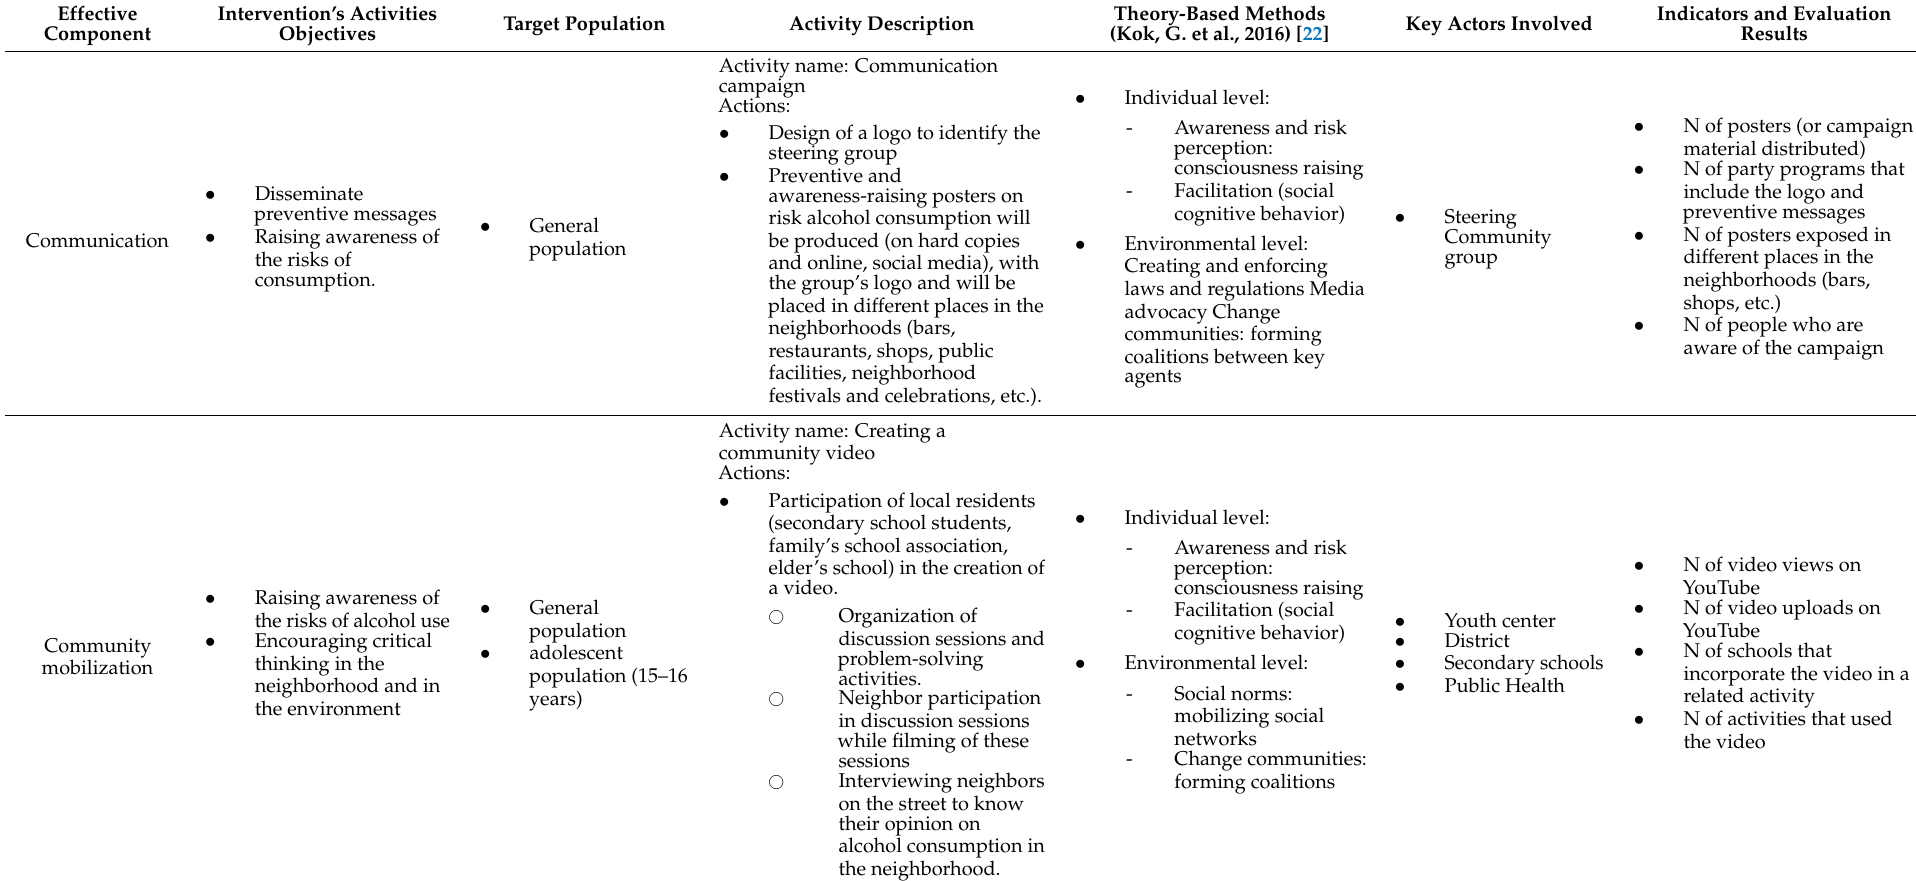
Table A2. Details of the intervention’s activities based on behavioral models and usual neighborhoods